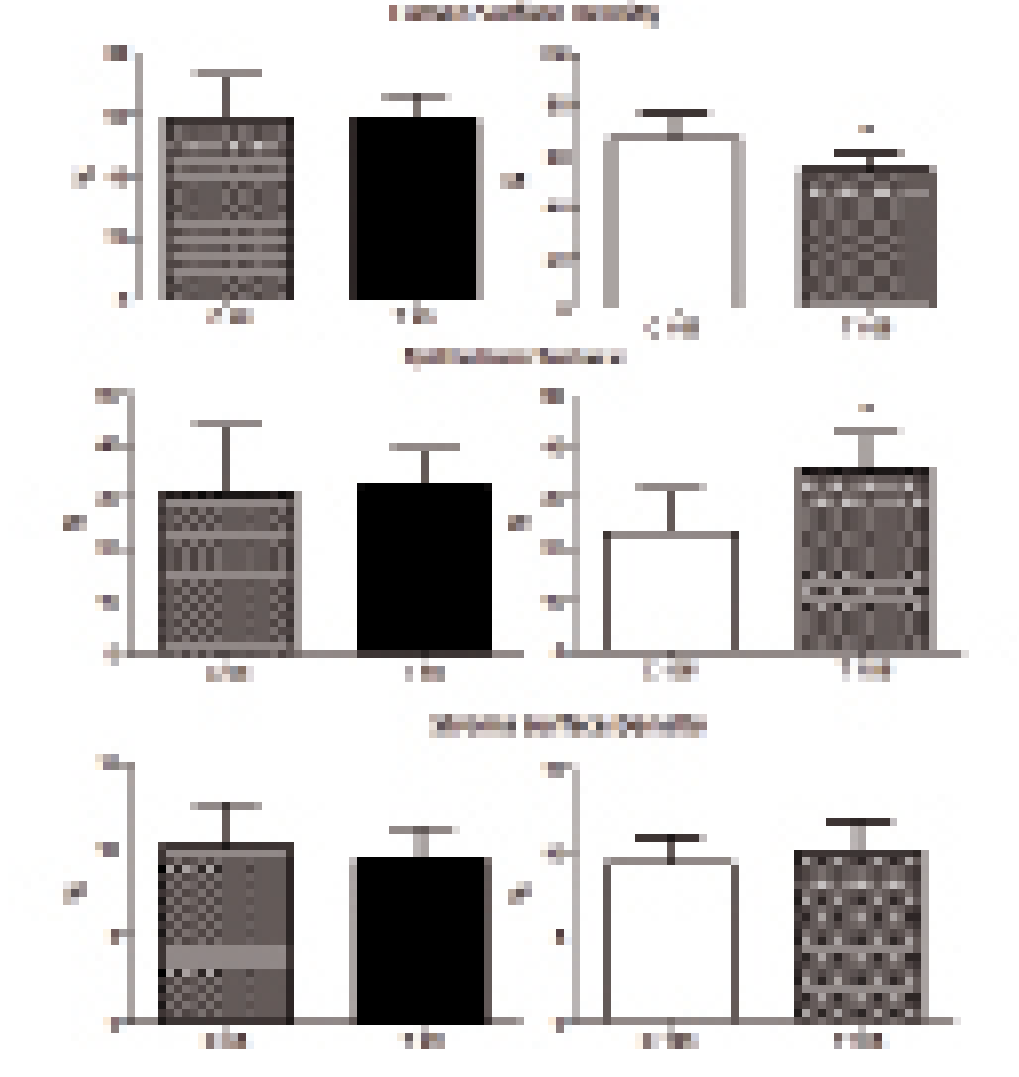
Figure 4 - Comparative graphs between surface densities of the lumen, epithelium and stroma of control and treated rats. Data expressed as mean and sD. *p < 0.05. The lumen surface density presented no difference between C65 and T65 (p = 0.9031) and for T105 presented a decreased of 19% compared to C105 (p = 0.0061). The epithelium surface density presented no difference between C65 and T65 (p = 0.7375), but increased by 51% (p = 0.0065) in T105 in relation to C105. There